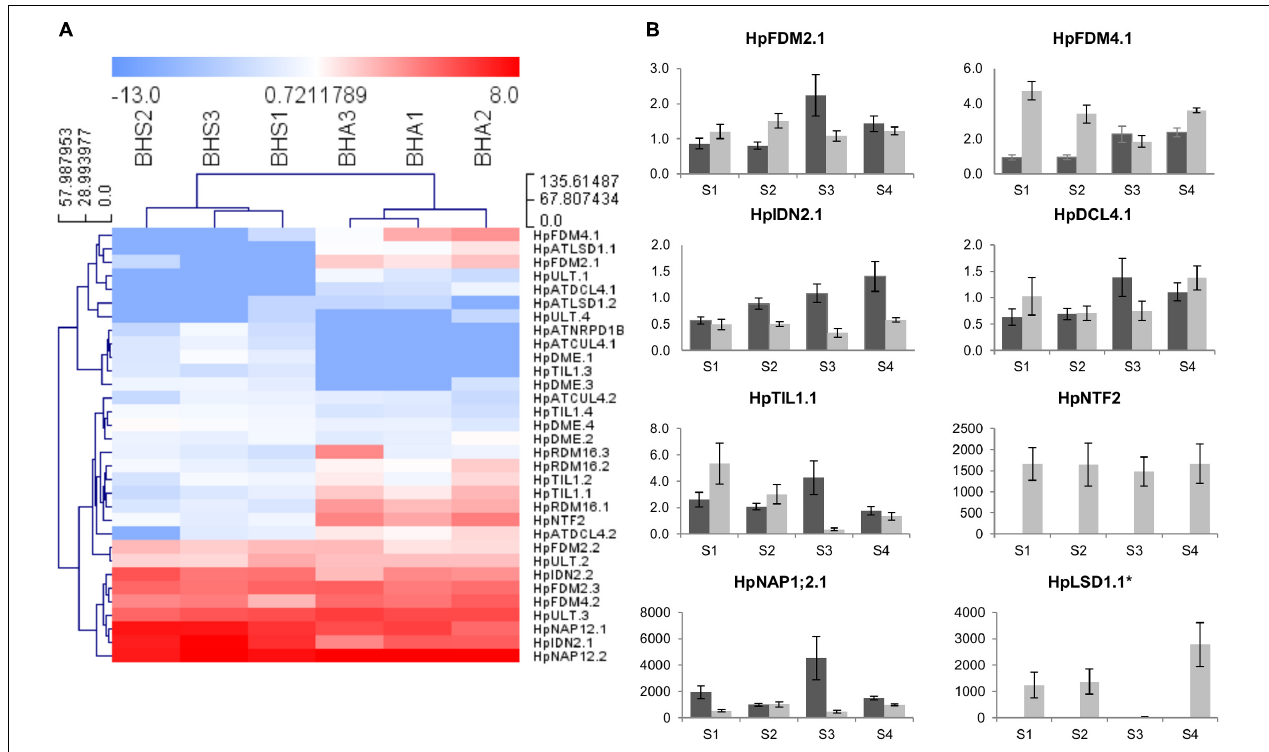
FIGURE 6 | Expression of H. perforatum loci involved in epigenetic regulation of gene expression. (A) Heat map showing the expression of transcript variants in ovules dissected from sexual and aposporic accessions, as assessed by RNAseq. The HCL was performed by using Manhattan distances and average linkage clustering. (B) Quantitative Real-Time PCR results for a number of loci involved in epigenetic regulation of gene expression. Light gray bars: relative expression level in sexual pistils; dark gray bars: relative expression level in aposporous pistils. Pistil developmental stages: S1: pre-meiosis; S2: meiosis; S3–S4 early and late gametogenesis, respectively. Relative expression values are plotted on the vertical ax. Error bars indicate the standard error observed among the five biological replicates. ∗ : the expression was detected in three apomictic samples out of